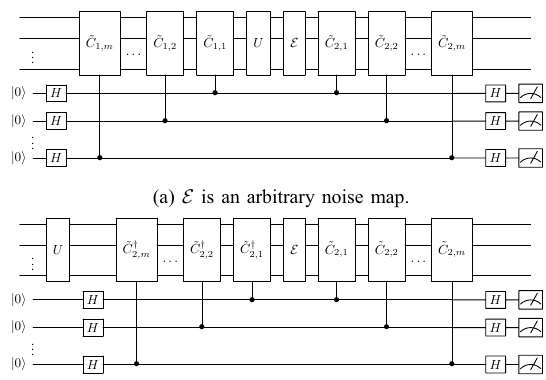
Figure 4. Noisy multilayer